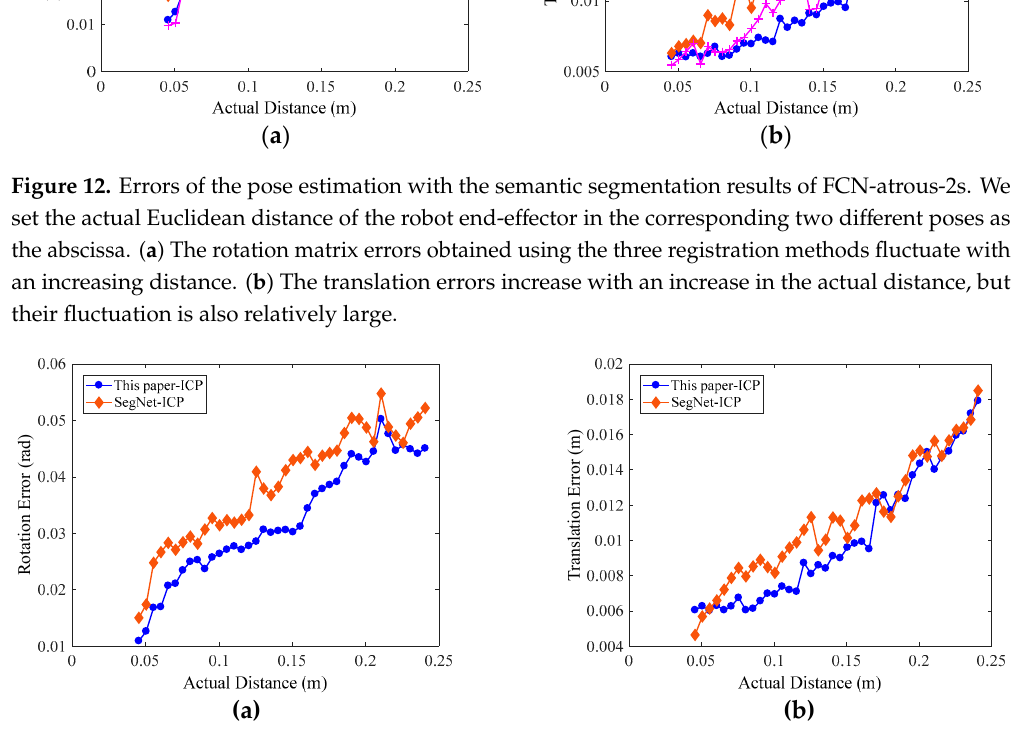
Figure 13. Errors of the pose estimation with FCN-artous-2s and SegNet, respectively. We set the actual Euclidean distance of the robot end-effector in the corresponding two different poses as the abscissa. ( a ) The rotation matrix errors. ( b ) The translation errors. The errors are obtained by using two semantic segmentation method and also increase with an increase in the actual distance.